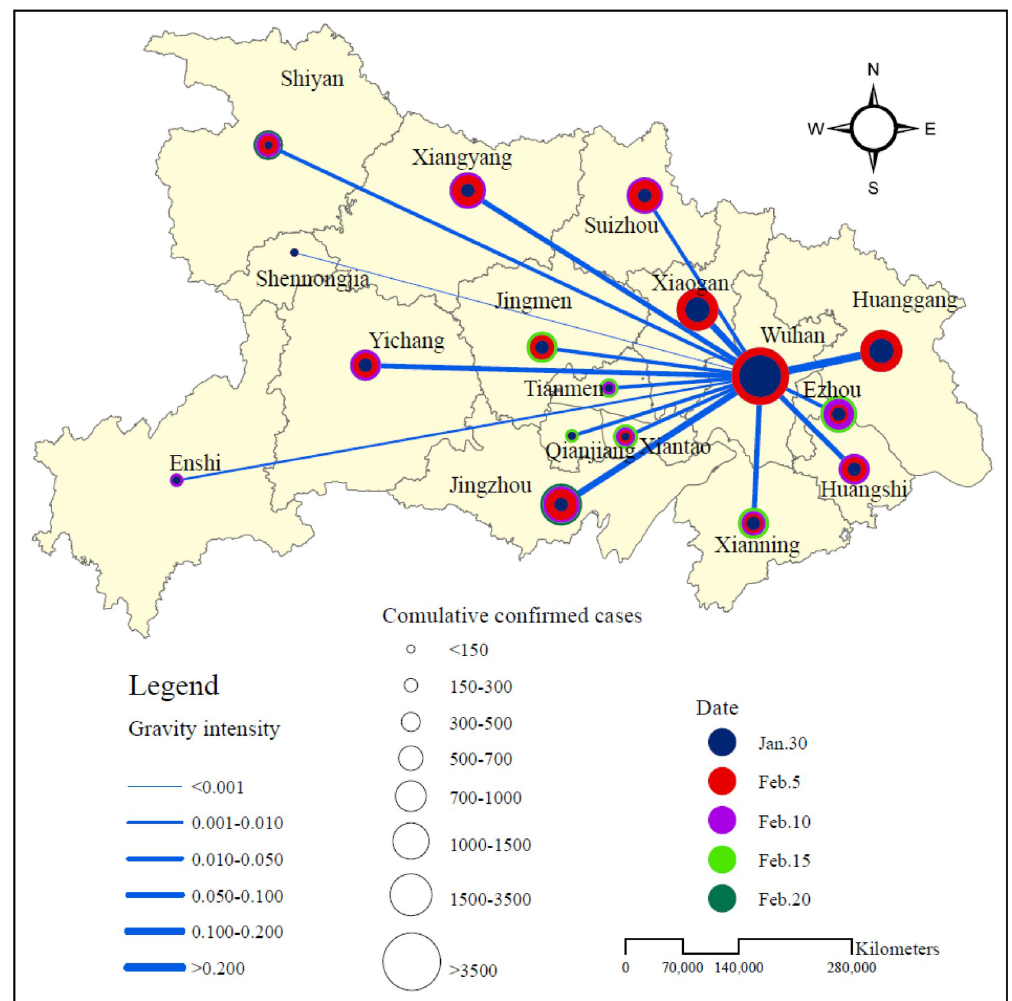
Fig 1. Local gravity intensity and epidemic diffusion between Wuhan and other regions in Hubei Province (2020). As shown in the figure, five representative dates are selected to illustrate the scale of the epidemic diffusion. The size of circles represents the scale. The gravity intensity is expressed according to the results calculated from the data of February 20, and the flow intensity is expressed through the line width. The line segments illustrate the vertical diffusion from Wuhan to other cities in Hubei. The horizontal diffusion relationship between other cities outside Wuhan are not shown. The vertical diffusion is described by local gravity model, and the horizontal diffusion is tested by spatial autoregressive analysis.